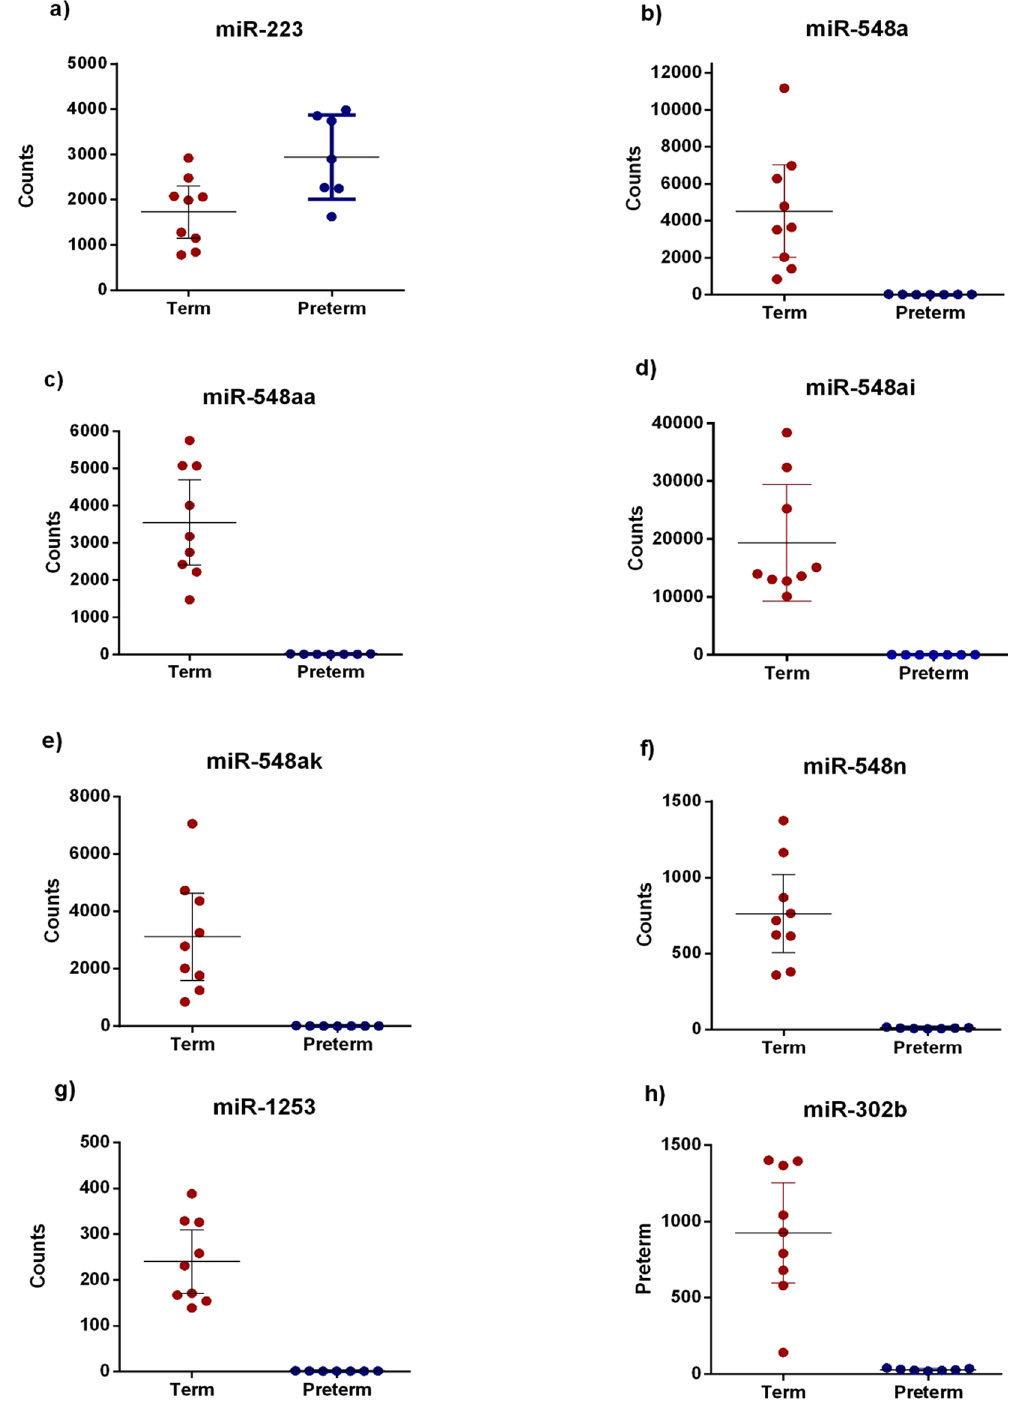
Figure 1. MiRNA profiles in maternal plasma at 20 weeks gestation. Graphs show digital counts of endogenous miRNAs from human maternal plasma at 20 weeks in women who went on to deliver at term or experience SPTB at 28–32 weeks. Individual data are presented along with min-max points with n = 7–9 per group. Data mean + 95% CI, p < 0.0001 for all differences for term vs. preterm. Significance was assumed if p < 0.001 by Student